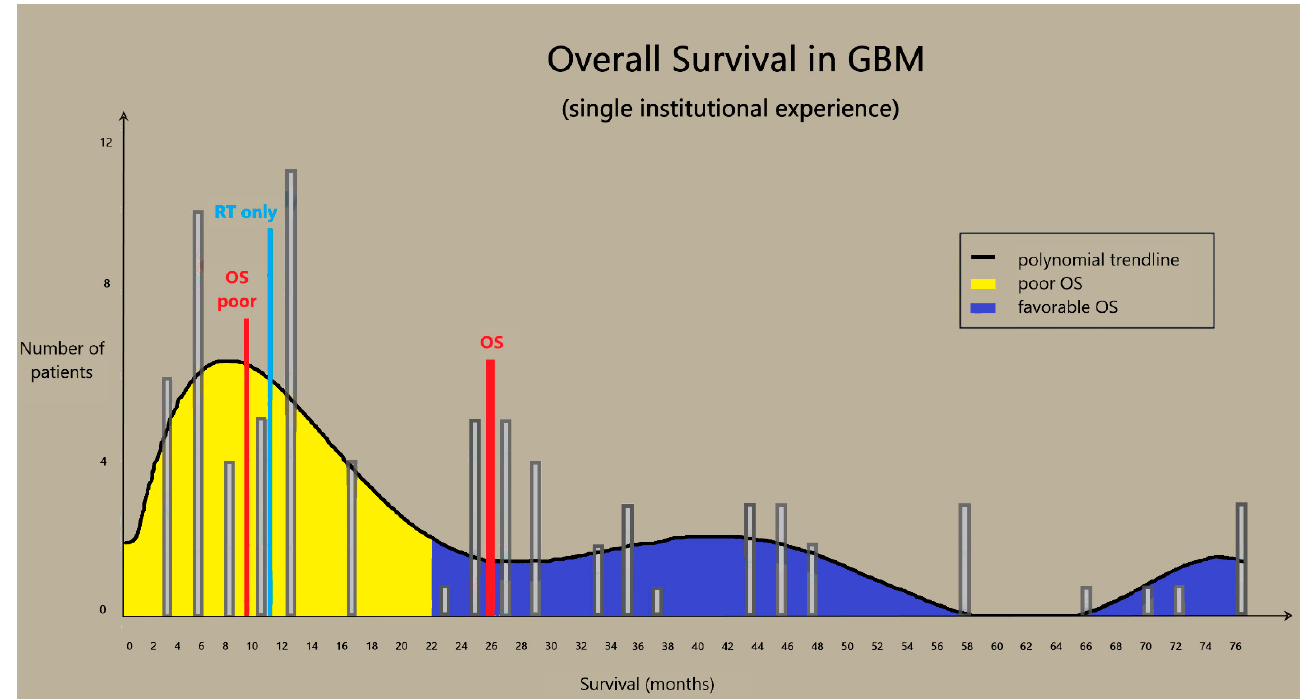
Figure 2. Overall survival in GBM (single institutional experience). Overall survival of patients treated (at least with concurrent chemo irradiation) with glioblastoma at our institution. The polynomial trend line shows three peaks. The first represents patients with poor prognosis—their median overall survival (OS poor) do not differ significantly from those who were treated only with radiotherapy (RT only) prior to Stupp era. The second and third peaks represent patients with a favorable prognosis. OS: Median overall survival of all examined patients.